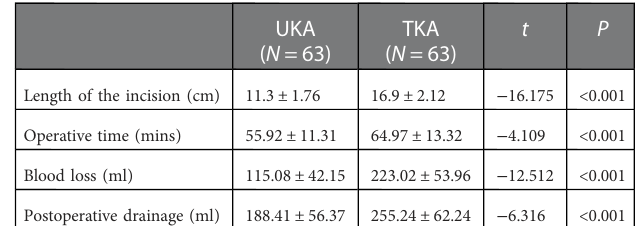
TABLE 2 Intra-operative